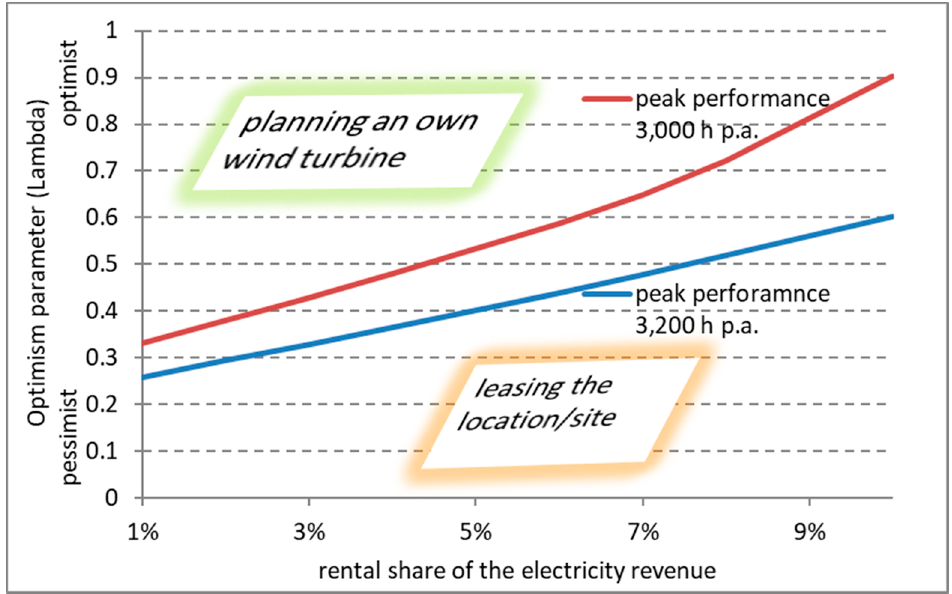
Figure 7. Decision to start planning wind turbines (3000 h or 3200 h peak performance) with an uncertain outcome compared with leasing the site depending on the rental share of the electricity revenue and the investor’s risk attitude.